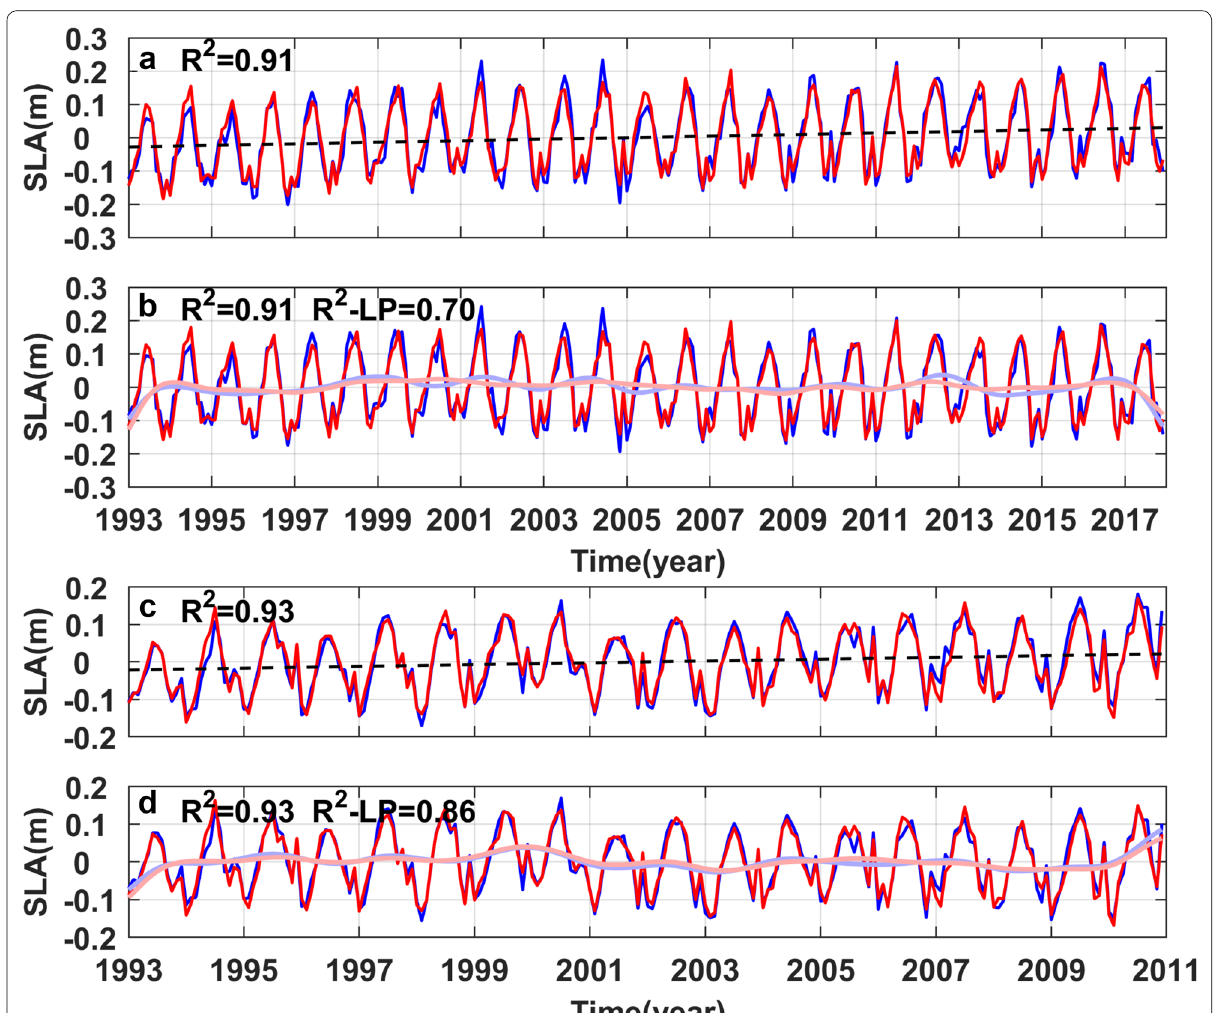
Fig. 6 Comparison of monthly averaged SLA at tide gauge stations (blue) and monthly averaged SLA from Eq. 2 (red) south of KE the jet ( a ) and north of the KE jet ( c ), superimposed with the long-term trends (dashed lines). b and d are the same as a and c with long-term trends removed, superimposed with 1-year low-pass